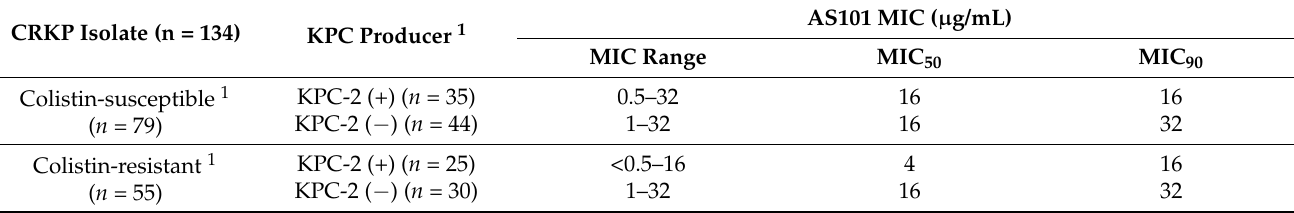
Table 1. Antimicrobial susceptibility of AS101 against 134 CRKP isolates.